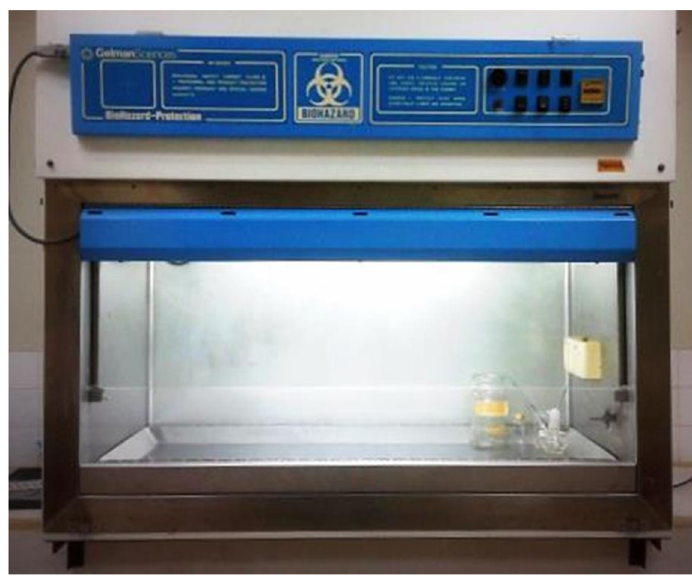
Figure 2. UV-C lamp in a laminar flow cabinet.